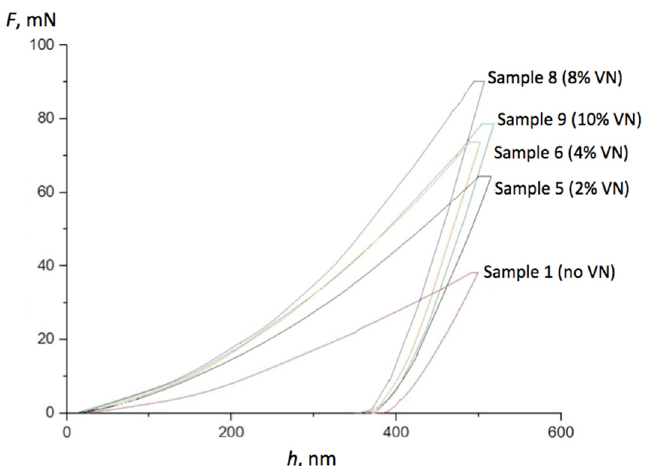
Figure 2. Plots of the force F versus the depth h during loading–unloading nano-indentation cycles for samples 1, 5, 6, 8, and 9, respectively. Table 2. Mechanical characteristics of sintered matrix material 51Fe–32Cu–9Ni–8Sn and of nano-VN inclusions in